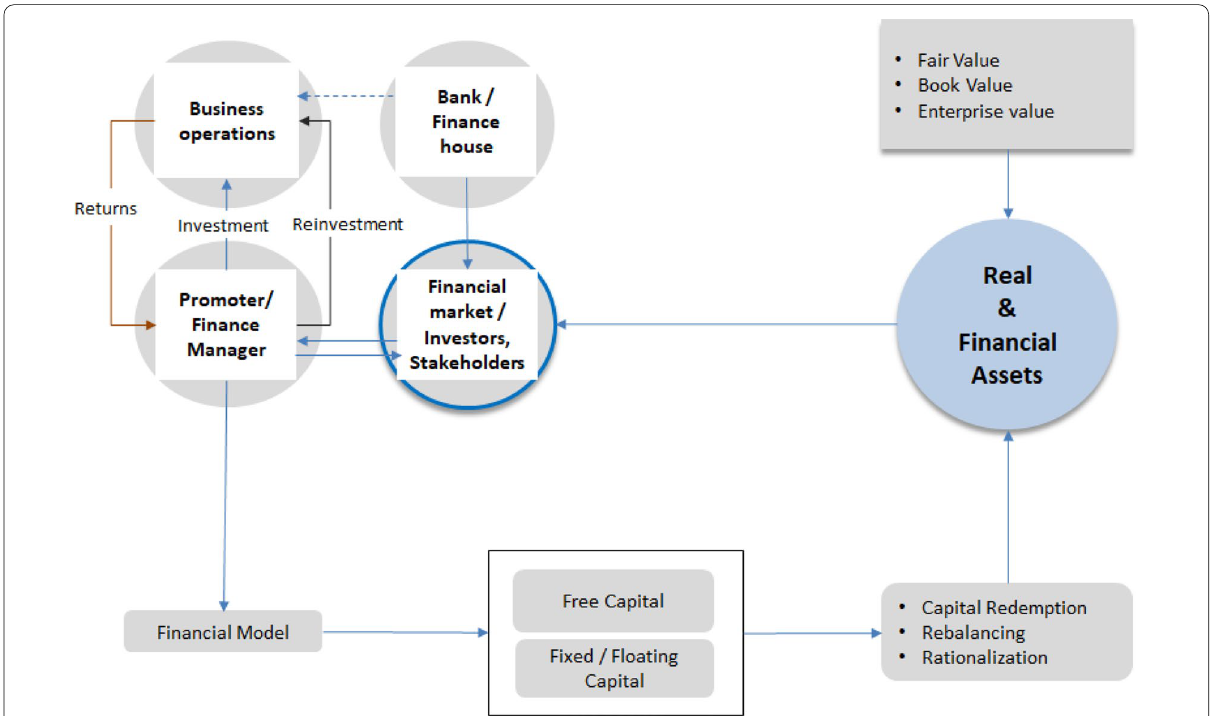
Fig. 6 Illustration of the relationship among the financial entities and processes in corporate